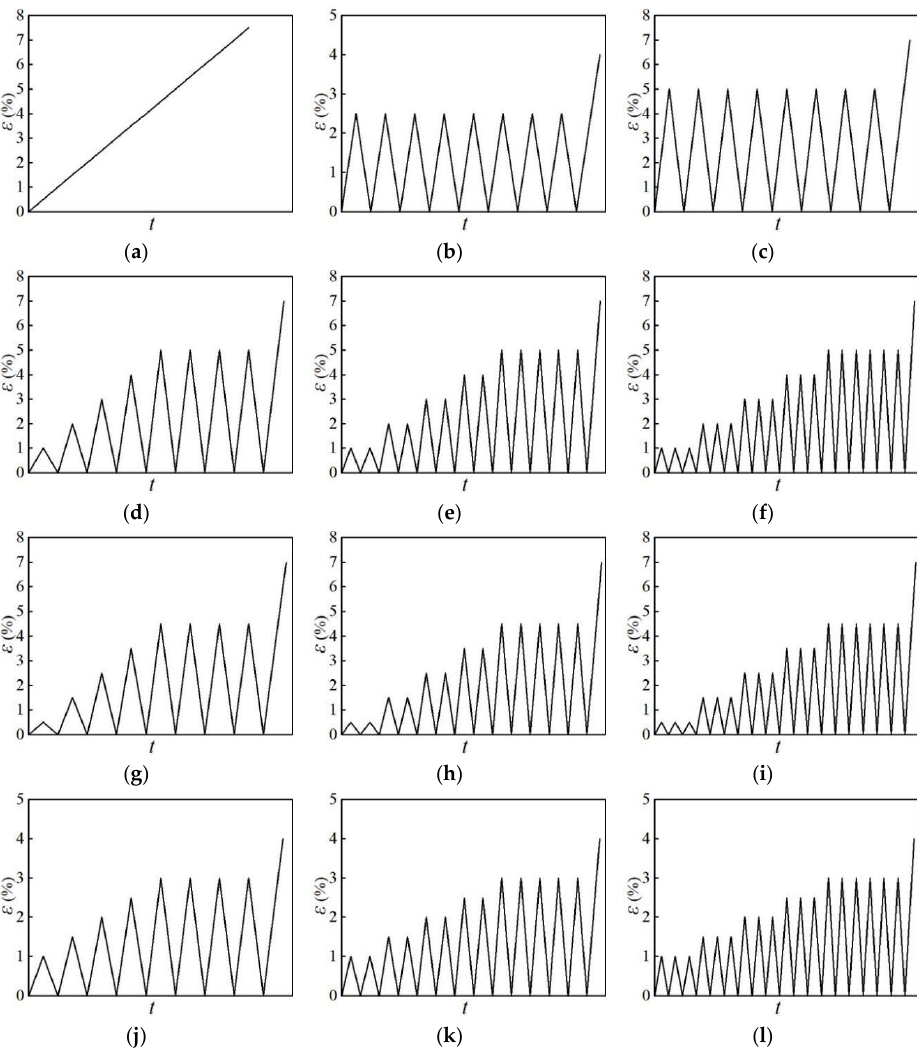
Figure 3. Loading patterns of specimens (Units: s): ( a ) loading pattern NM-1; ( b ) loading pattern NM-2-1; ( c ) loading pattern NM-2-2; ( d ) loading pattern NM-3-1; ( e ) loading pattern NM-3-2; ( f ) loading pattern NM-3-3; ( g ) loading pattern NM-4-1; ( h ) loading pattern NM-4-2; ( i ) loading pattern NM-4-3; ( j ) loading pattern NM-5-1; ( k ) loading pattern NM-5-2; ( l ) loading pattern